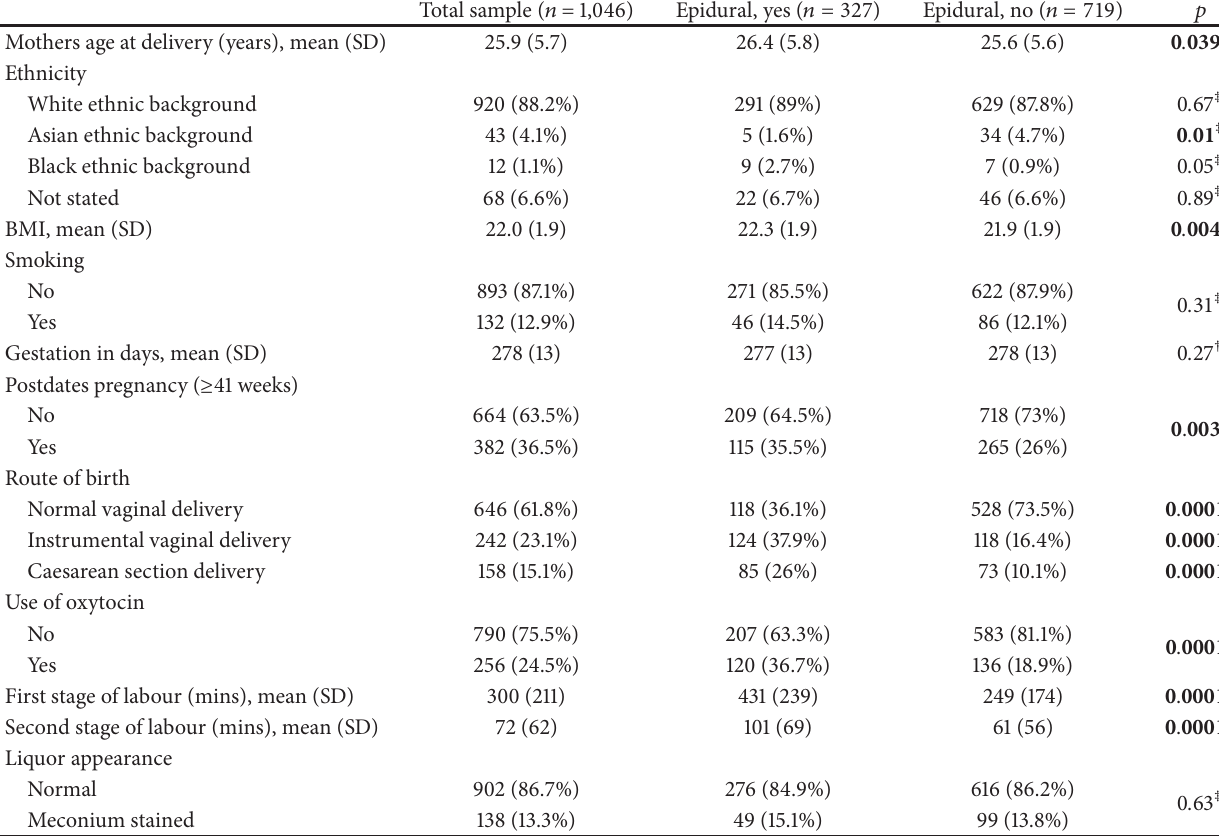
Table 1: Maternal demographics and labour/delivery characteristics.